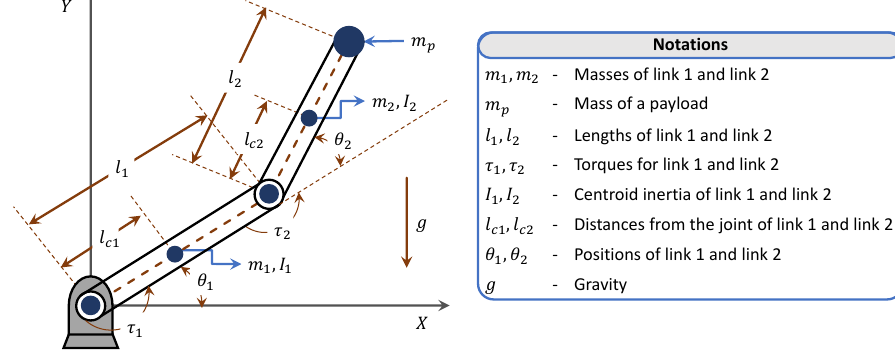
Figure 7. Two-link planar rigid robotic manipulator with a